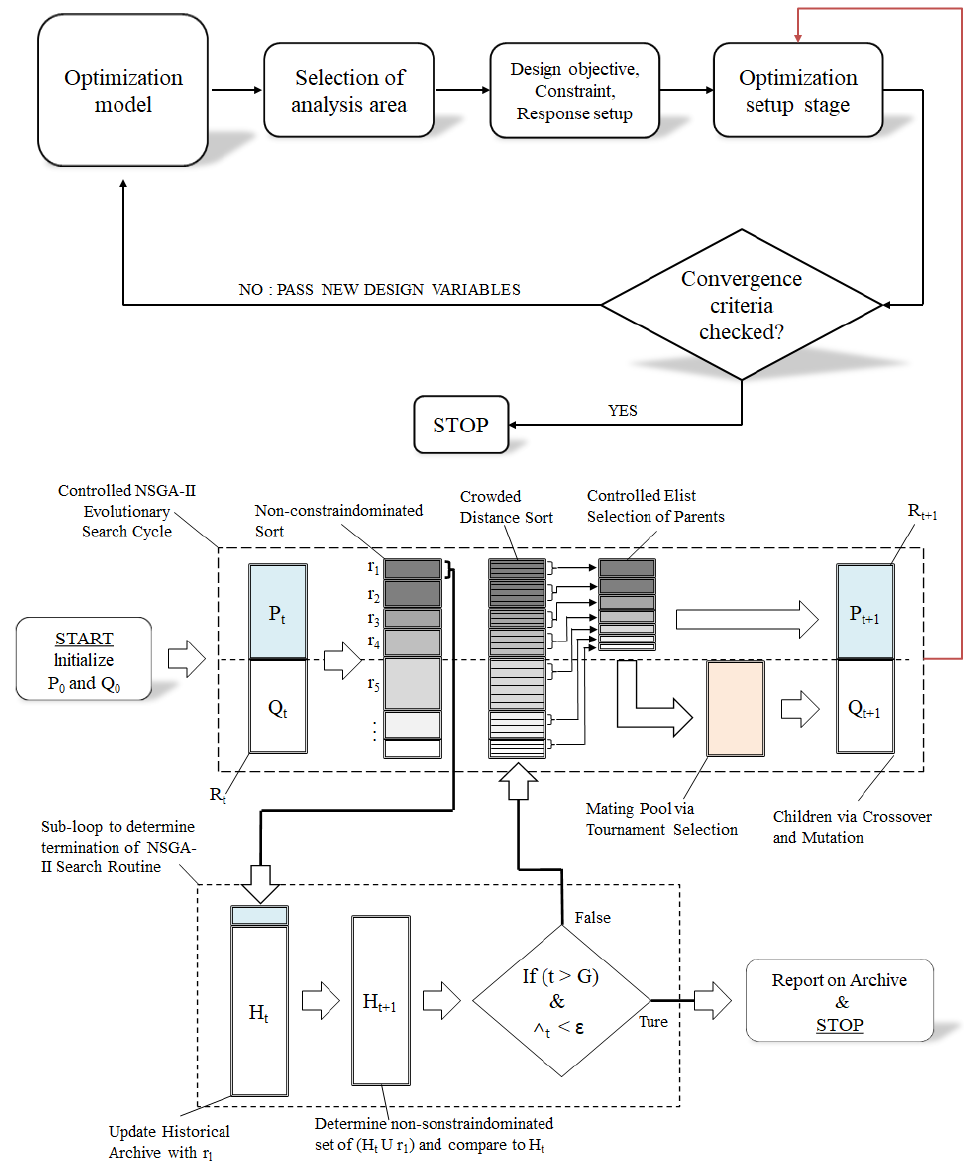
Figure 5. Process of operating a genetic algorithm for a composite wing structure [32].